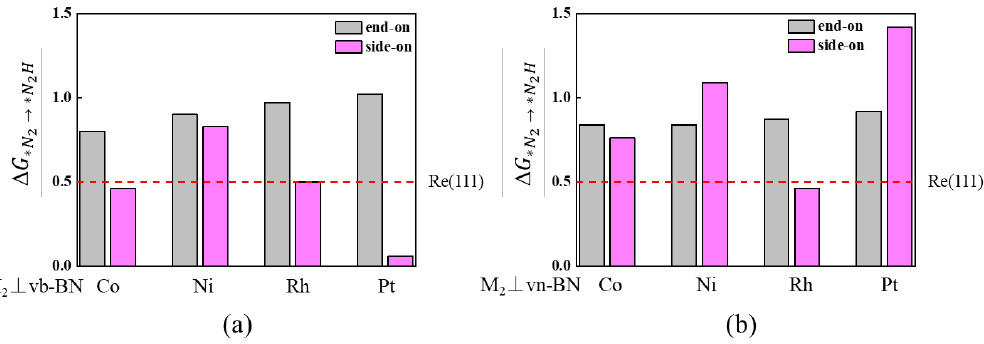
Figure 2. Three typical reaction pathways, including distal (blue), alternating (red) and enzymatic (dark blue) routes for NRR.